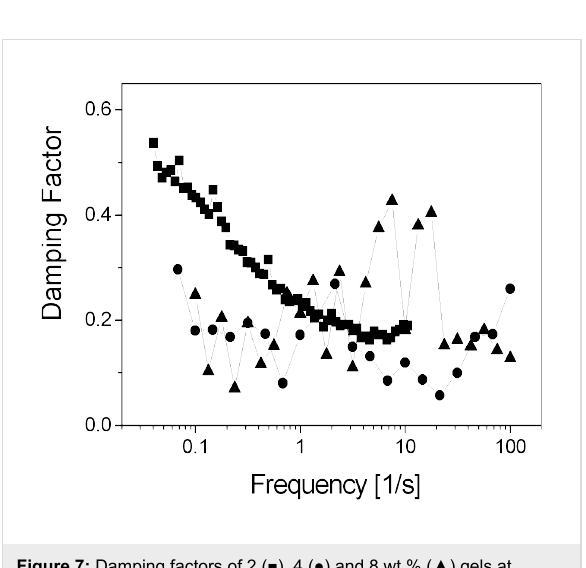
Figure 7: Damping factors of 2 ( ■ ), 4 ( ● ) and 8 wt % ( ▲ ) gels at different